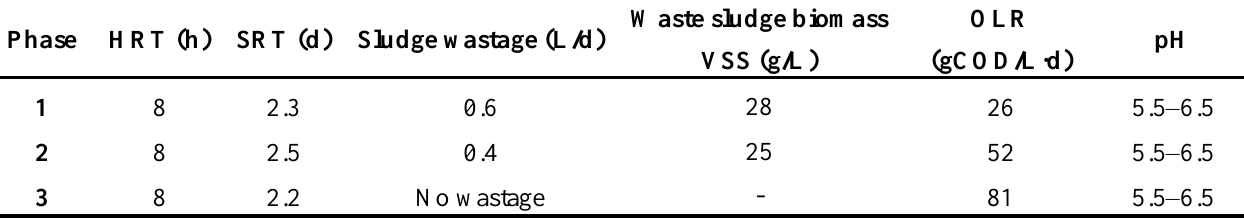
Table 2. Operational conditions of the